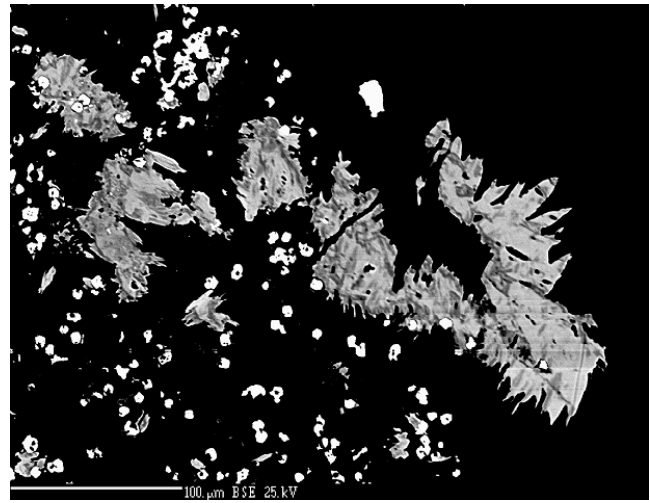
Figure 48. Zonation of Se-rich chalcostibite euhedral aggregates caused by variable Se-S content. BSE photo. P ř íbram, a dump of shaft 16. Photo by J. Sejkora and P. Škácha.